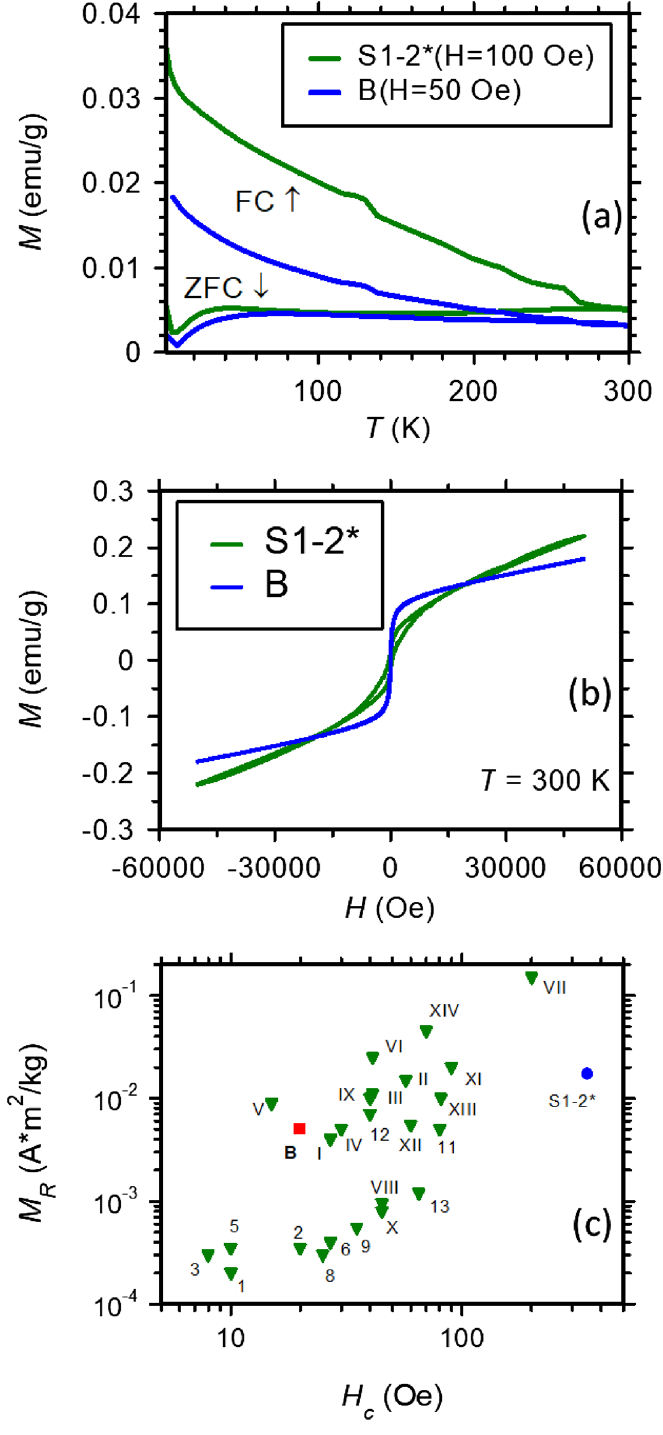
Figure 11. ( a ) Magnetization curves with temperature at a magnetic field of 100 Oe for S1–2* and 50 Oe for sample B; ( b ) the magnetic hysteresis curves at 300 K; ( c ) distribution of remnant magnetization ( M R ) against the coercive field ( H C ) of the burnt brick samples S1–2* and B from Romula in comparison with data for soils (Arabic numeral) and burnt bricks (Roman numeral) from ref. 8